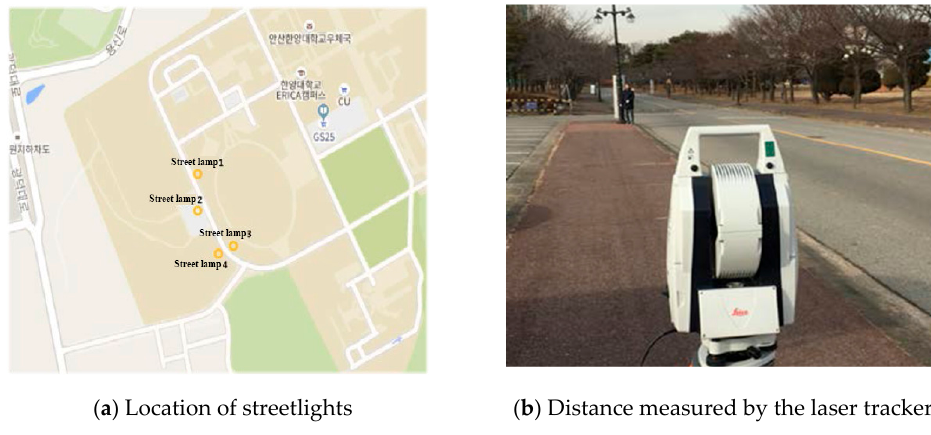
Figure 7. Operation of monitoring system of an autonomous vehicle. Table 6. Distances (mm) measured by a laser tracker (Leica/AT401).